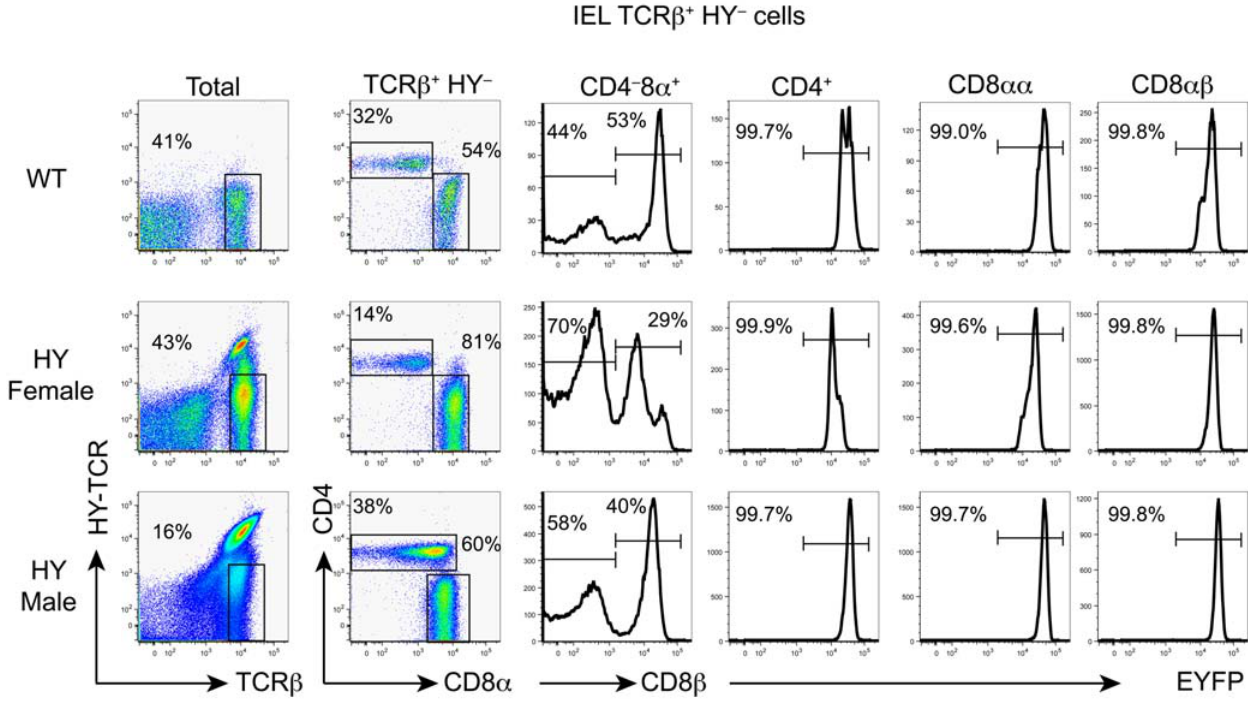
Figure 2. Fate mapping of IEL from WT and HY-TCR transgenic mice expressing endogenous TCR a using ROR c t-cre. CD4 and CD8 a expression by gated HY (T3.70) 2 TCR b + IEL (left column) is shown in the second column. CD8 b expression by gated CD8 a + cells (second column) is shown in the third column. EYFP expression by HY 2 CD4 + , HY 2 CD8 aa + and HY 2 CD8 ab + T cells is shown. doi:10.1371/journal.pone.0001512.g002 PLoS ONE |